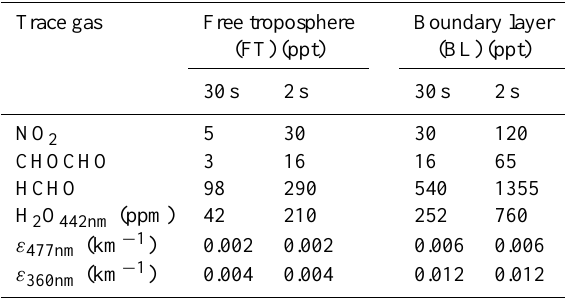
Table 3. Detection limits of CU AMAX-DOAS instrument in the clean free troposphere and the boundary layer in polluted urban con- ditions like SCAB for different integration times. Detection limit was calculated as 1 σ RMS detection limit for the aerosol scenario presented in the Fig.